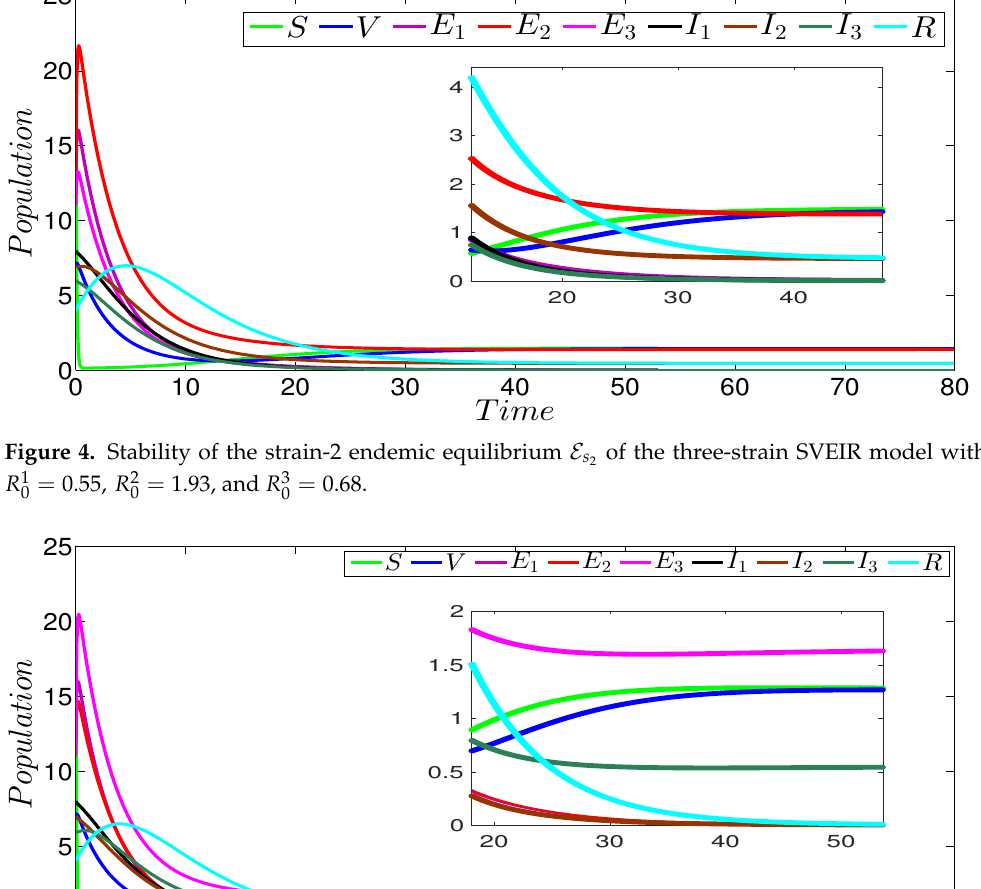
Figure 5. Stability of the strain-3 endemic equilibrium E s R 2 = 0.82, and R 3 0